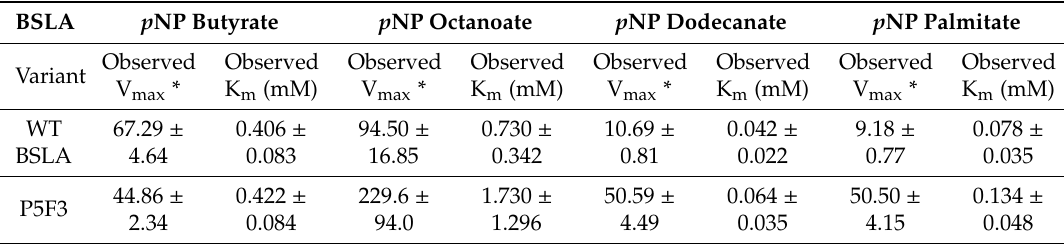
Figure 5. Thermal ( A ), isopropanol ( B ), and Triton X-100 ( C ) resistance for wildtype BSLA and variant P5F3. Thermal resistance for P5F3 is decreased in comparison to WT BSLA, however, isopropanol and Triton X-100 resistance is increased. Table 3. Kinetic parameters observed for wildtype BSLA and variant P5F3 from concentrated cell culture supernatant obtained from Michaelian fitting of the initial rate values resulting from substrate saturation experiments using p -nitrophenyl butyrate, octanoate, dodecanoate, and palmitate. Enzyme concentration was estimated by SDS-PAGE analysis and relative quantification of the protein bands corresponding to BSLA using Biorad’ ImageLab software, the enzyme concentration in both samples could be estimated and standardized for each reaction. Michaelis–Menten fitting and kinetic parameter estimation were performed using GrapPad Prism 8.